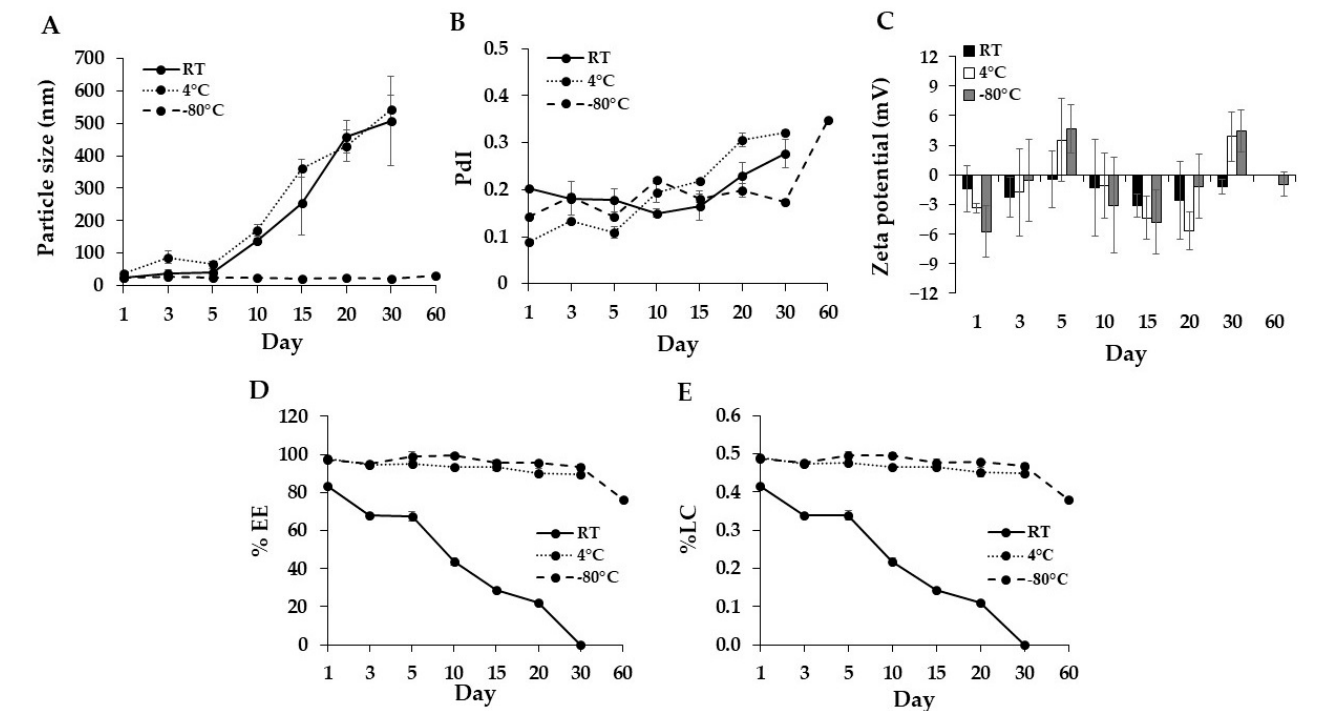
Figure 5. The variations in particle size ( A ), polydispersity index (PdI) ( B ), zeta potential ( C ), %EE of Dox ( D ), and %LC of Dox in Dox-micelle ( E ) after 30 and 60 days of storage at room temperature (RT), 4 °C, and − 80 °C in the dark, respectively. Size, PdI, zeta potential, % EE, and % LC data were presented as mean ± SE ( n = 3).